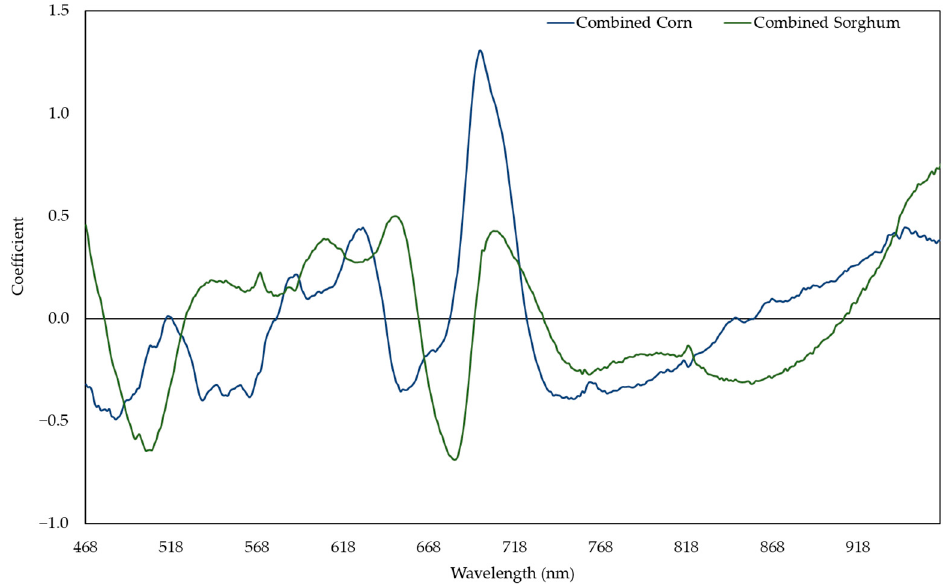
Figure 8. Coefficient in models predicting nitrogen content with the responses of combined sorghum or combined corn.